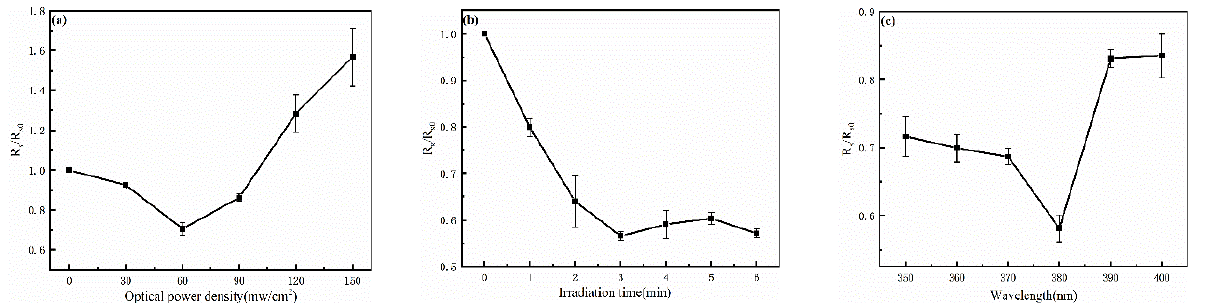
Figure 3. Influence of different factors on the sheet resistance of the UV welded AgNWs. ( a ) Sheet resistance of AgNWs varies with the UV irradiation power. ( b ) Sheet resistance of AgNWs varies with the UV irradiation time. ( c ) Sheet resistance of AgNWs varies with the UV wavelength.